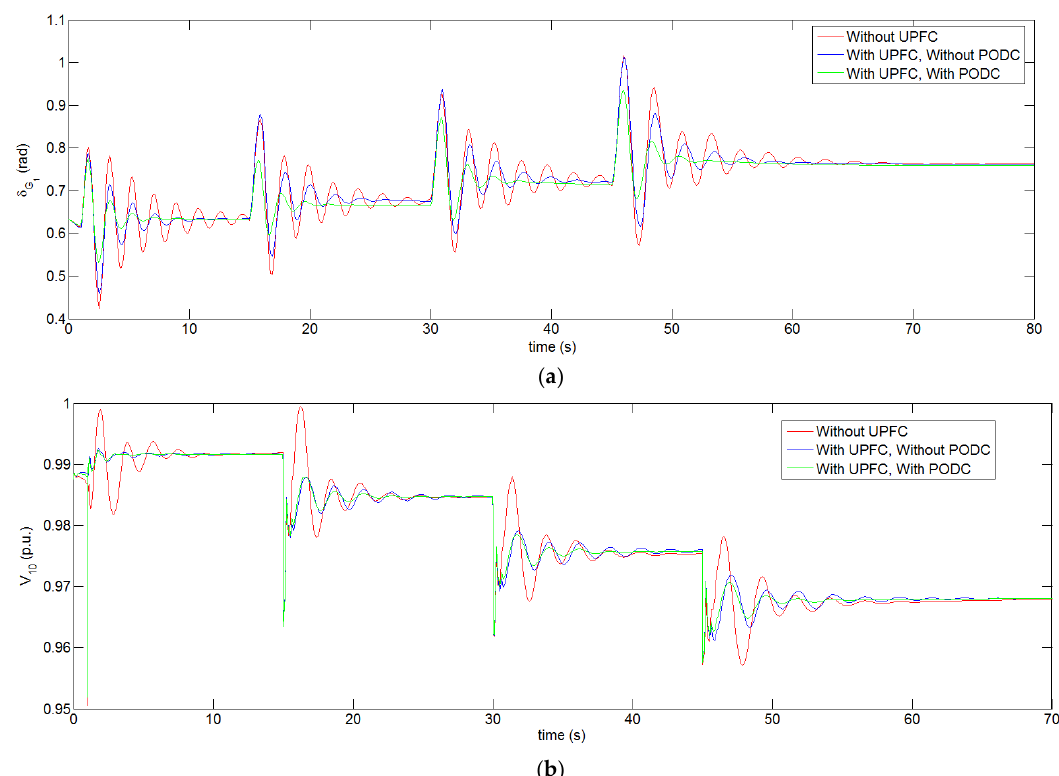
Figure 11. Dynamic responses subject to variations of the load at bus 7 and the wind power output: ( a ) power angle curves of G 1 , and ( b ) voltage curves at bus 10.